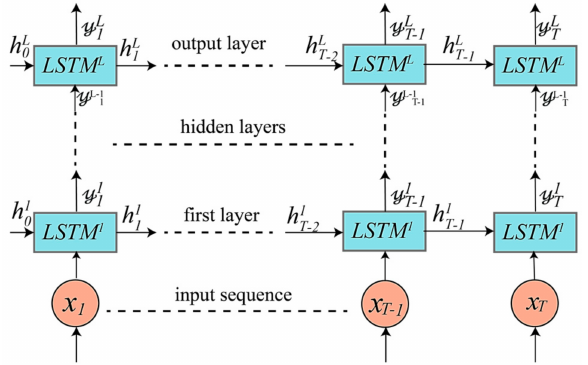
Figure 4. Unidirectional LSTM-based DRNN model consisting of an input layer, several hidden layers, and an output layer. The number of hidden layers is a hyperparameter that is tuned during